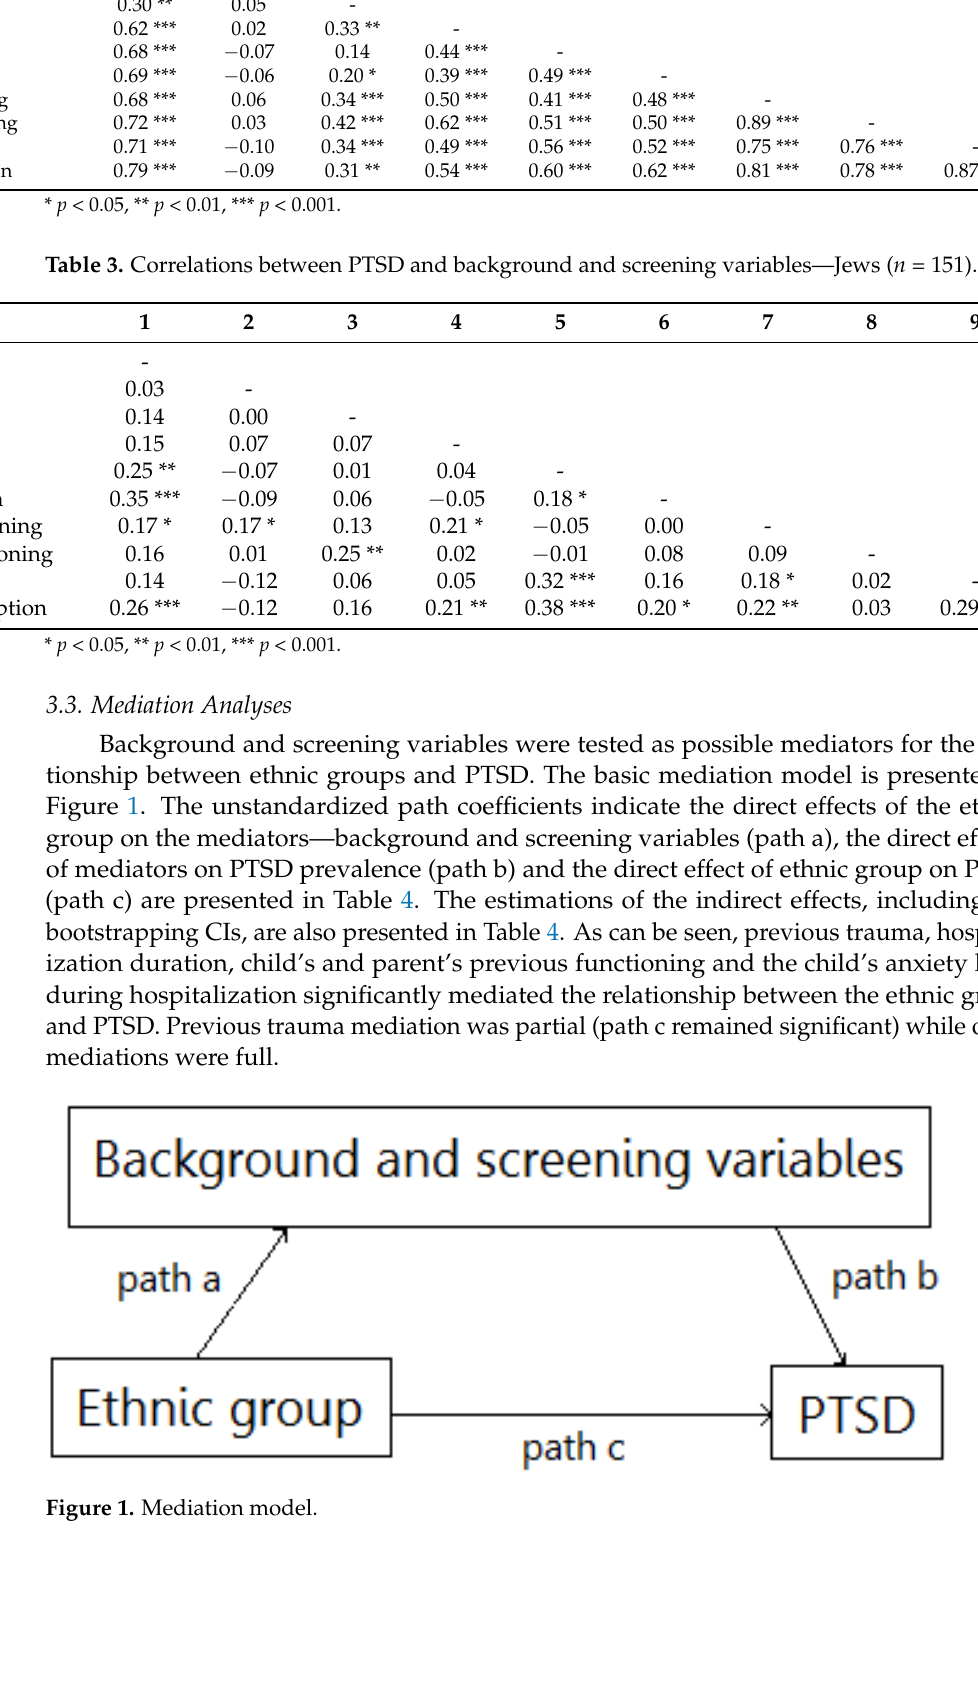
Figure 1. Mediation